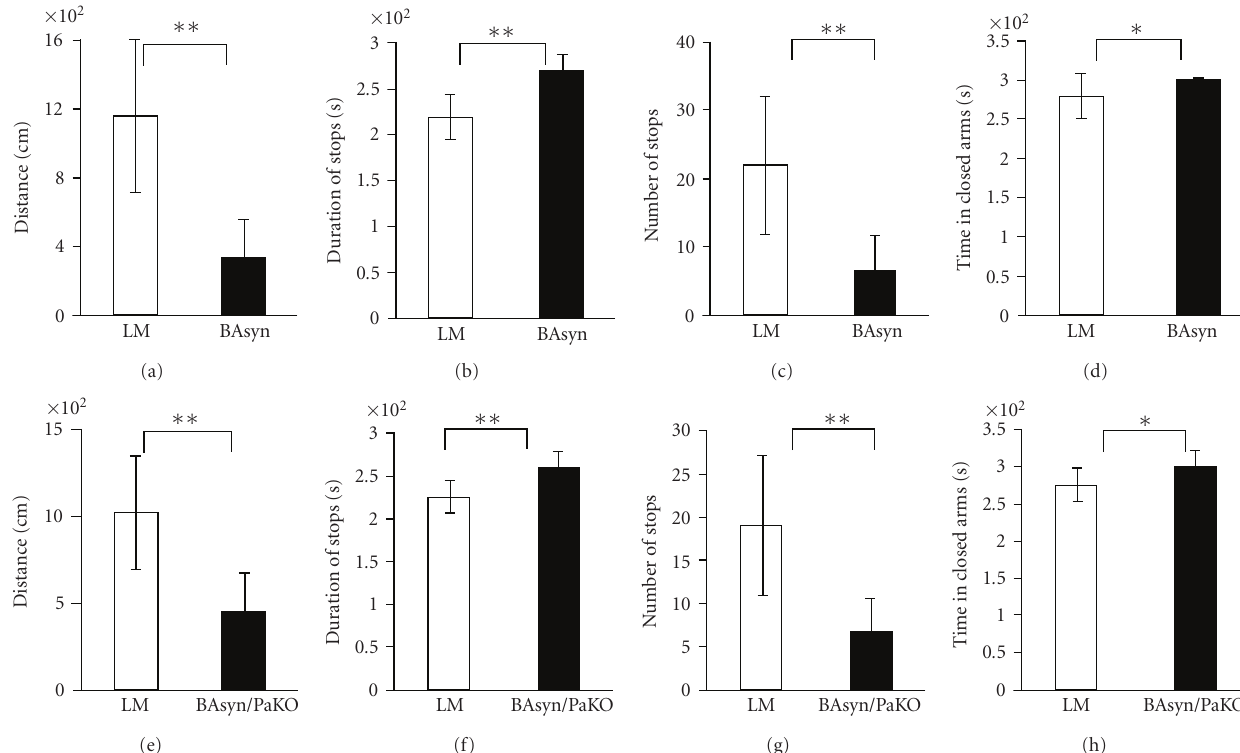
Figure 5: Elevated plus test performance of 8m-old BAsyn and BAsyn/PaKO. Walked distance ((a), (e)), duration of stops ((b), (f)), number of stops ((c), (g)) , and time spent in closed arms ((d), (h)) are shown, n = 6–9, error bars = SD, U -test, ∗ P < . 05, ∗∗ P < . 01.